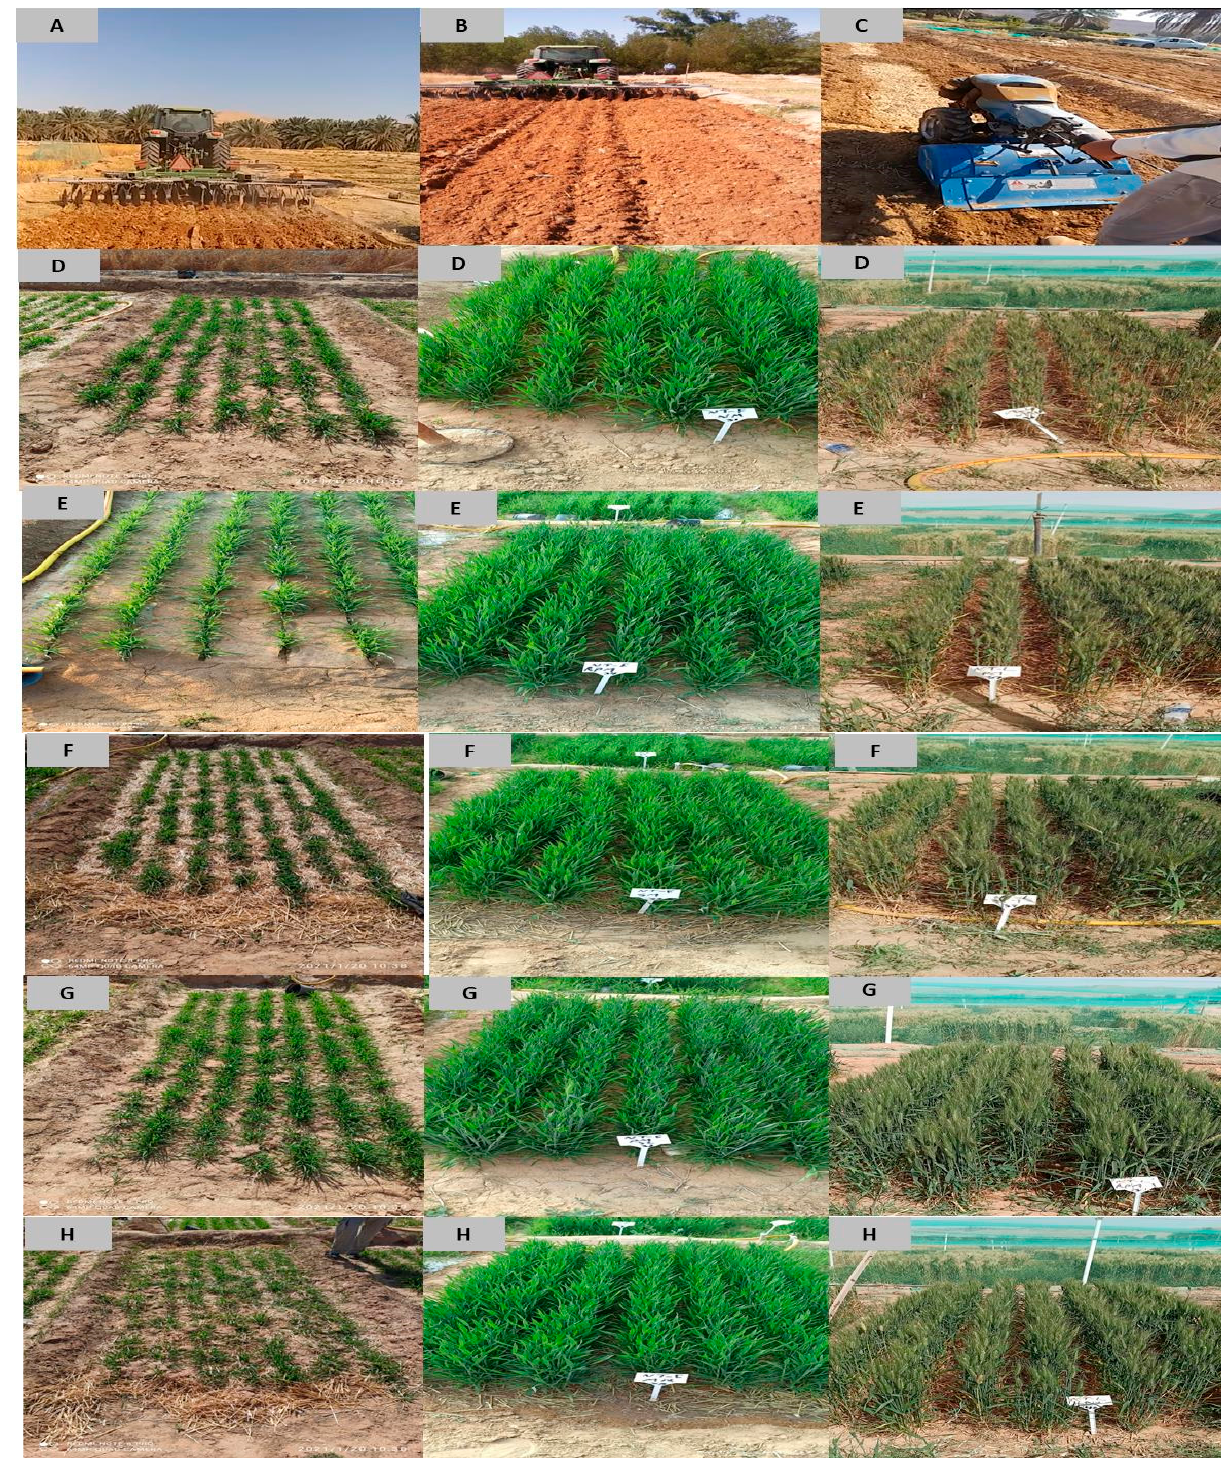
Figure 1. Plot layouts of different tillage and mulching practices. ( A ) conventional tillage practice